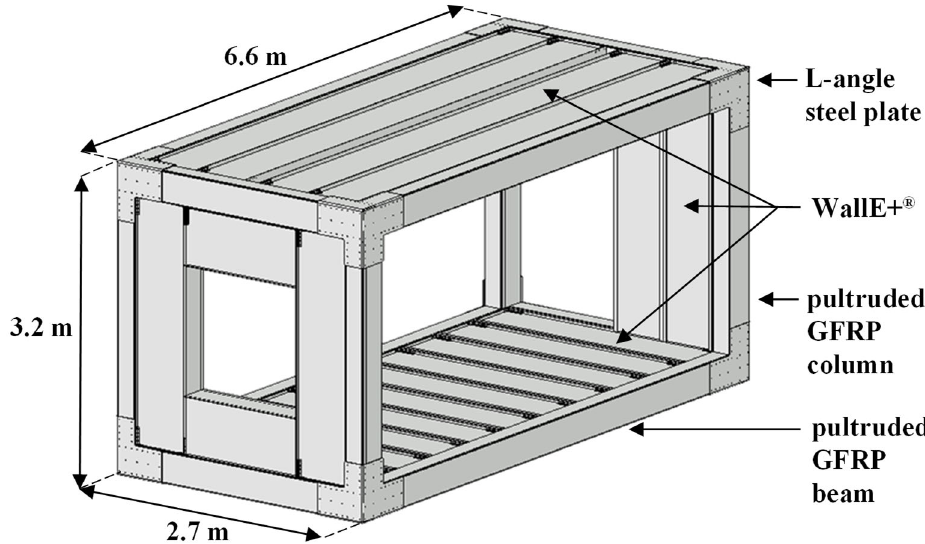
Figure 1. 3D representation of the MOOVABAT modular element.